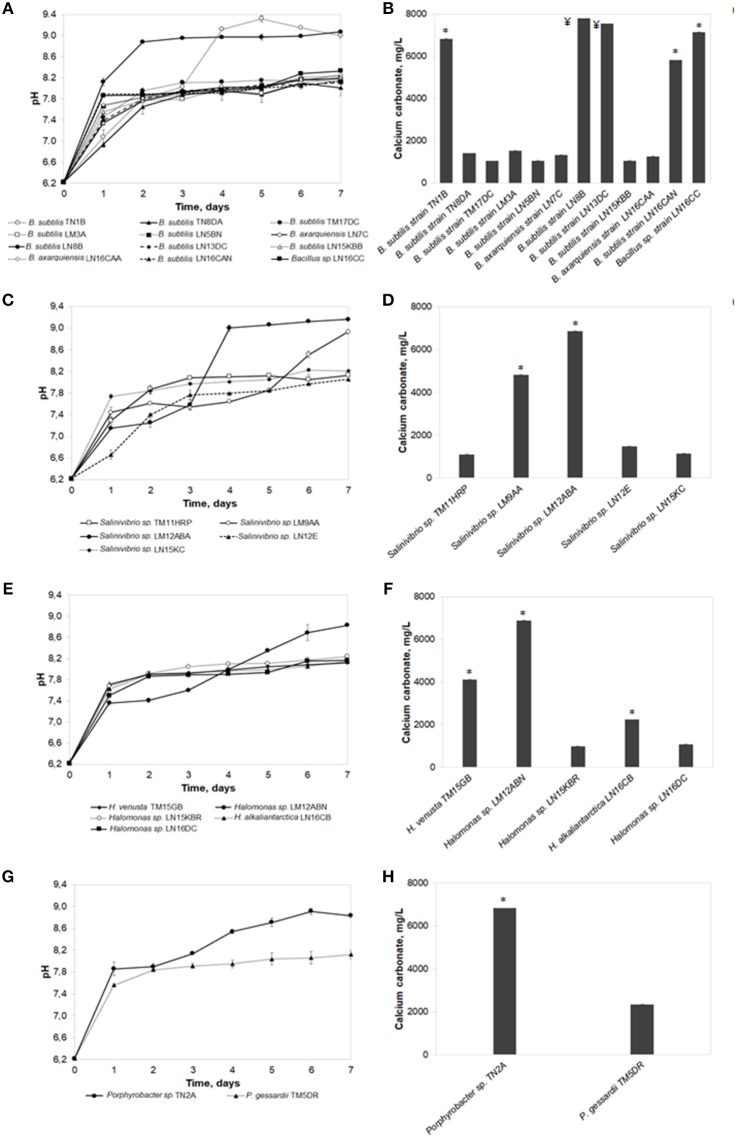
The freshwater biomineralization test. pH evolution and calcium carbonate precipitation of bacterial strains belonging to Bacillus genus (A,B), Salinivibrio genus (C,D), Halomonas genus (E,F), and others genera (G,H). Error bars show the standard deviations for three replications per sample. Asterisks indicate significant differences (p < 0.05) among the values. ¥ indicates no significant differences among the values but there being differences with respect to all the other isolates.